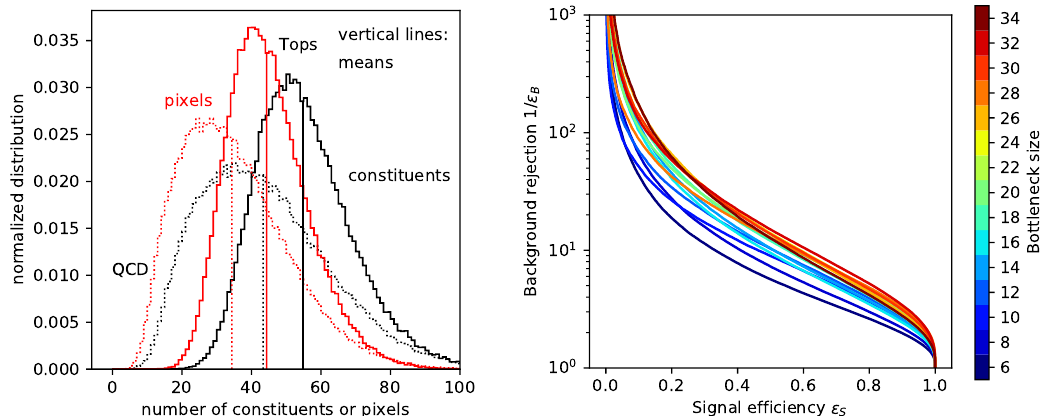
Figure 1: Left: numbers of constituents and of non-zero pixels for tops and QCD jets, 400,000 jets in total. Right: ROC curves for the image-based autoencoder identifying anomalous top jets for different bottleneck sizes.